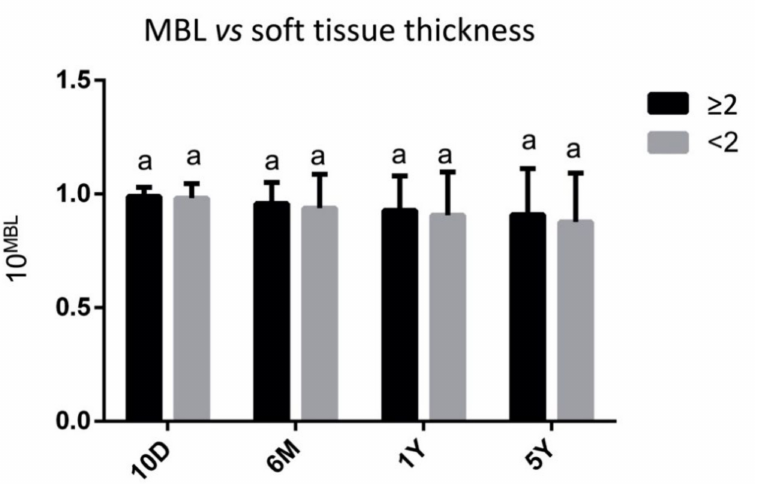
Figure 4. Marginal bone loss (MBL) calculated at 10 days (10D), 6 months (6M), 1 year (1Y) and 5 years (5Y) after surgical procedure, in relation with different soft tissues thickness ( ≥ 2 mm